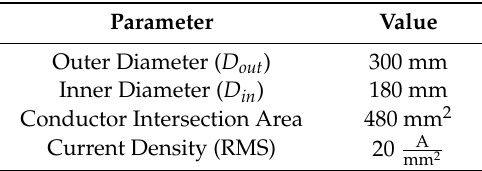
Table 1. Stator parameters.